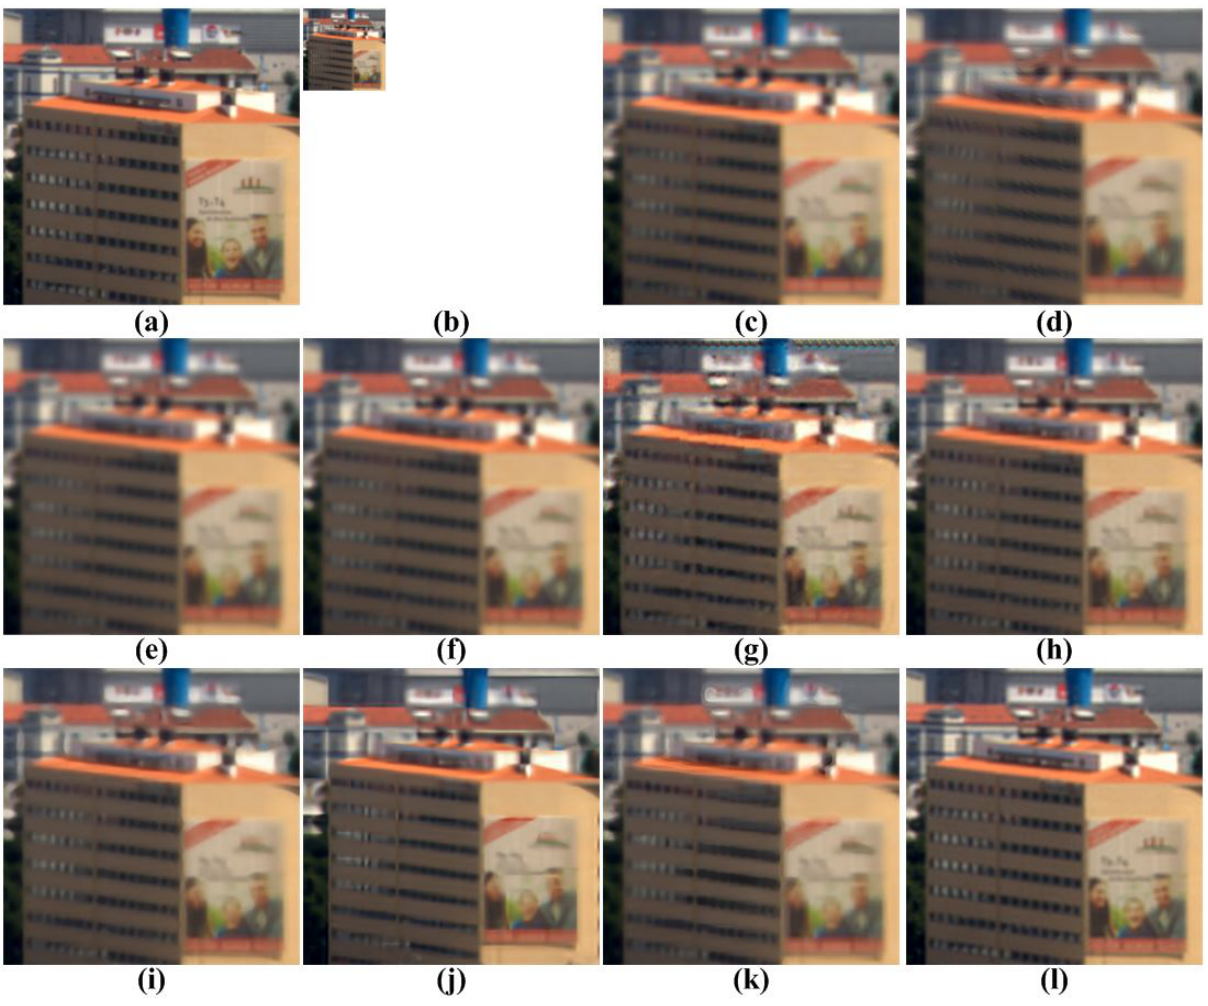
Figure 5. Results of resolution enhancement by enlarging a simulated low-resolution (LR) multispectral image: ( a ) cropped original HR image in Figure 4a; ( b ) the four-times down-sampled LR image; results of: ( c ) cubic-spline interpolation [3]; ( d ) interpolation-based SR [4]; ( e ) interpolation-based SR [5]; ( f ) interpolation-based SR [6]; ( g ) example-based SR [7]; ( h ) patch-based SR [9]; ( i ) patch-based SR [10]; ( j ) patch-based SR [11]; ( k ) patch-based SR [12] and ( l ) the proposed